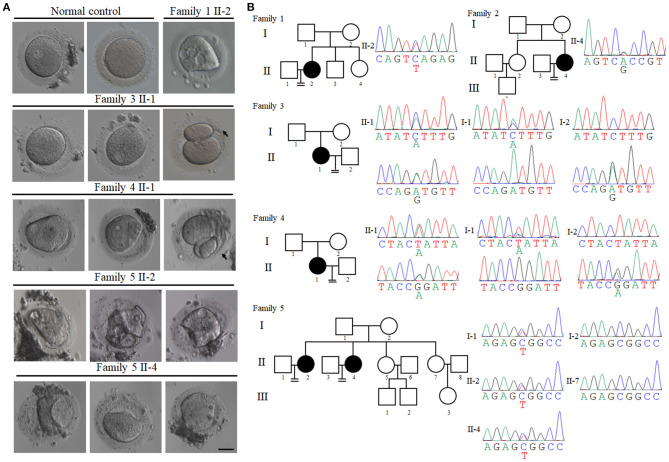
Clinical characterization and identification of PATL2 mutations in the infertile patients. (A) The morphology of oocytes [germinal vesicle (GV), metaphase I (MI), and first polar body (Pb1) oocytes] from normal and affected individuals with PATL2 mutations. Individuals from family 3 and 4 had Pb1 oocytes with abnormal polar body, as indicated by the arrows. The scale bar represents 50 μm. (B) Pedigrees of five affected families. Sanger sequencing confirmation is shown below the pedigrees. Solid indicates affected members, and equal signs denote infertility. Sanger sequencing result is shown beside the pedigrees. The mutations in the affected individuals from families 3, 4, and 5 were inherited from their parents. The patients in families 1 and 2 had unknown inheritance patterns. The patients in families 1 carried mutation c.C898T p.Q300* and family 2 carried mutation c.A1345G p.T449A. The patients in families 3 had the compound heterozygous mutations c.C1376A p.S459Y and c.A931G p.M311V. Compound heterozygous mutations c.G920A p.R307Q and c.T649A p.Y217N were identified in family 4. Heterozygous mutation c.C1336T p.R446W was identified in two sisters in family 5.